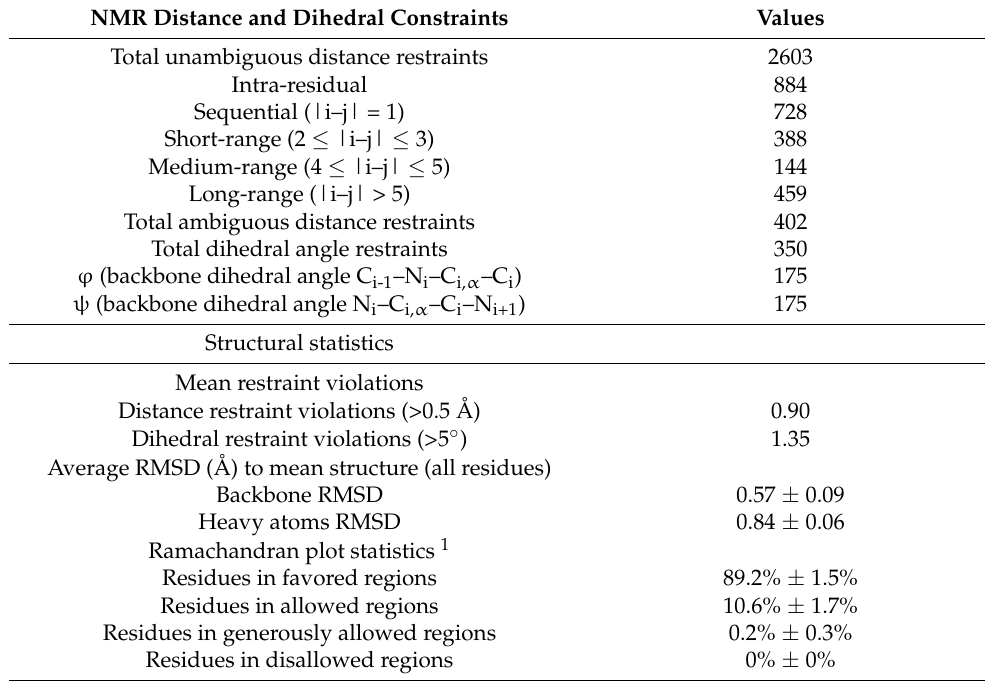
Table 1. NMR restraints and structural statistics for h